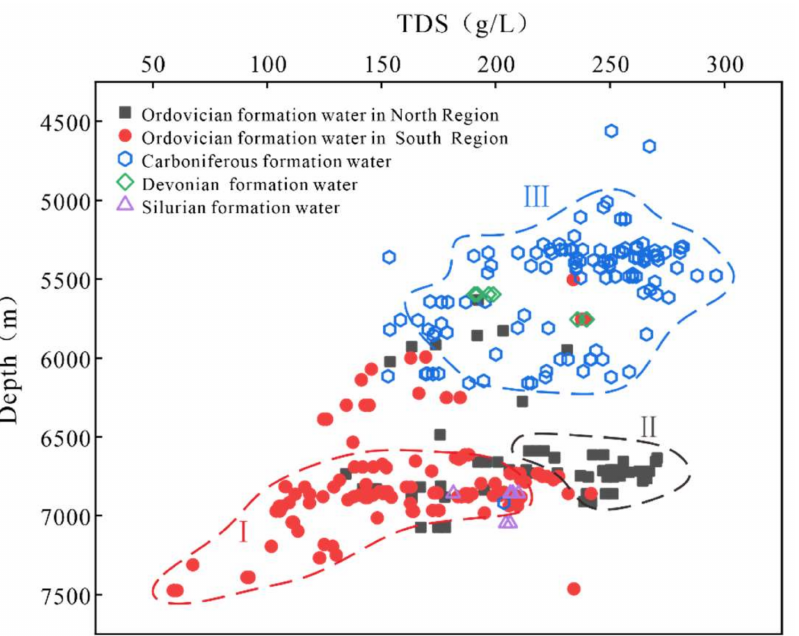
Figure 8. TDS of formation waters in different strata in Halahatang depression. Area I: The major part of the TDS data of Ordovician formation water in South Region; Area II: The major part of the TDS data of Ordovician formation water in North Region; Area III: The major part of the TDS data of Carboniferous formation water. The Carboniferous formation water has high TDS than Ordovician formation water in South Region.